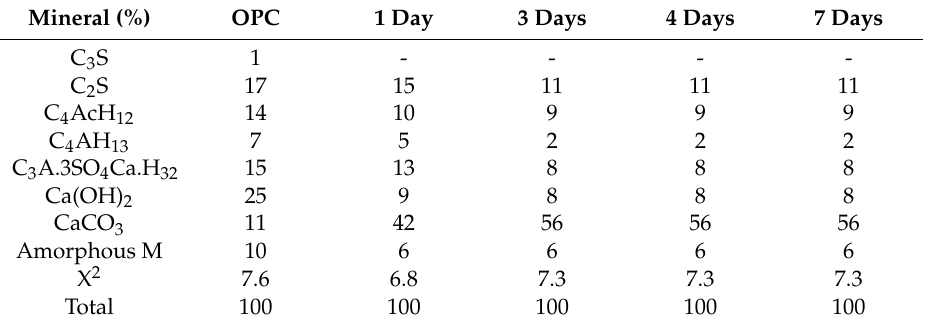
Table 3. Rietveld-refined mineralogical composition of 28 days cured OPC paste by time of exposure to accelerated carbonation.